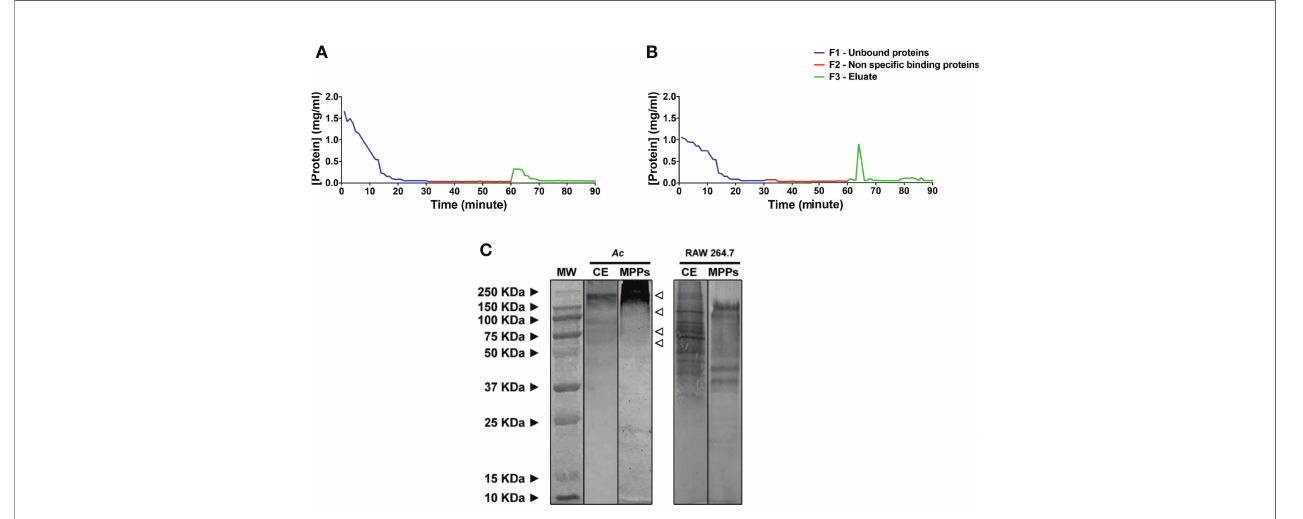
FIGURE 1 | Differences between the pro fi le composition of mannose-binding lectins on the surface of Acanthamoeba castellanii and macrophages. (A, B) Af fi nity chromatography with D-mannose agarose columns displaying the chromatogram results upon puri fi cation of surface extracts of (A) A. castellanii (Ac) and (B) RAW 264.7 macrophages. (C) Western blot, corresponding to clari fi ed and (MPPs, of Ac and macrophages. The molecular weight standard was used in the analysis. Lane MW: Molecular Weight Standard (Prestained ™ Standards, Kleidoscope ™ ); Lane Ac CE: Clari fi ed extract of Ac ; Line Ac MPPs: MPPs of Ac , with open arrows indicating the molecular weight of approximately 55 KDa, 75 KDa, 110 KDa and above 150 KDa; Lane RAW 246.7 CE: Clari fi ed extract of RAW 246.7 macrophages; Lane RAW 246.7